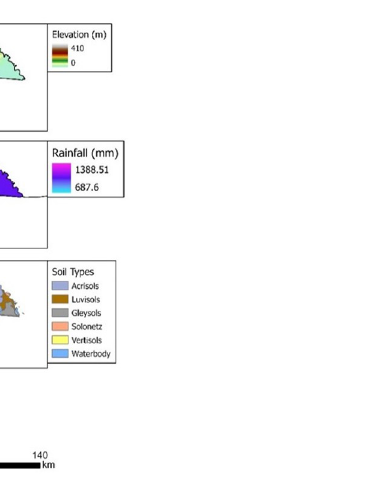
Fig 2. Natural variables for land cover change in the Greater Accra Region. Source: [36].